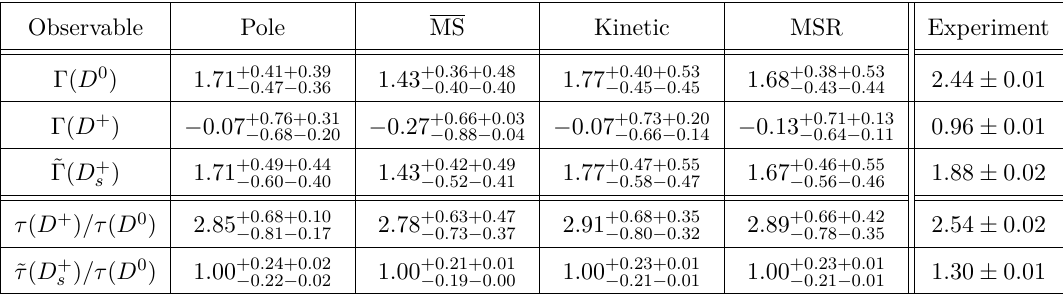
Table 10. The total decay widths in units ps − 1 , and their ratios for charmed mesons compared to the experimental values, using HQET parameters, see table 1 for the references to the experimental papers. The first uncertainties are coming from independent variations of the hadronic matrix elements within the corresponding ranges, while the second uncertainties result from the variation of the renormalization scale µ in the range [1 , 3] GeV. The references to the sources of the experimental data are given in section 2.1.1.